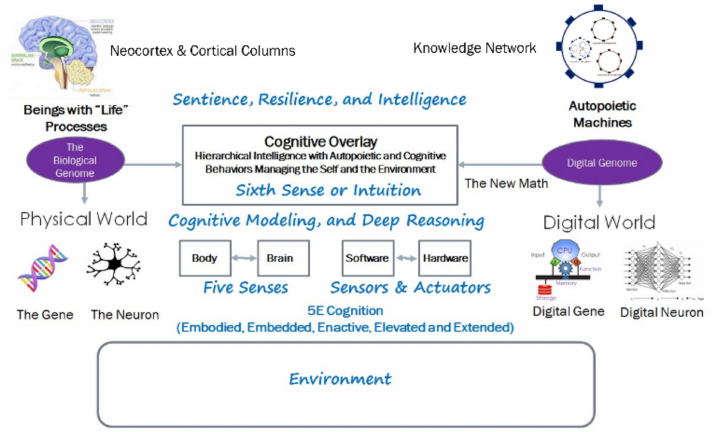
Figure 2. Structural machines depicting natural and digital autopoietic and cognitive